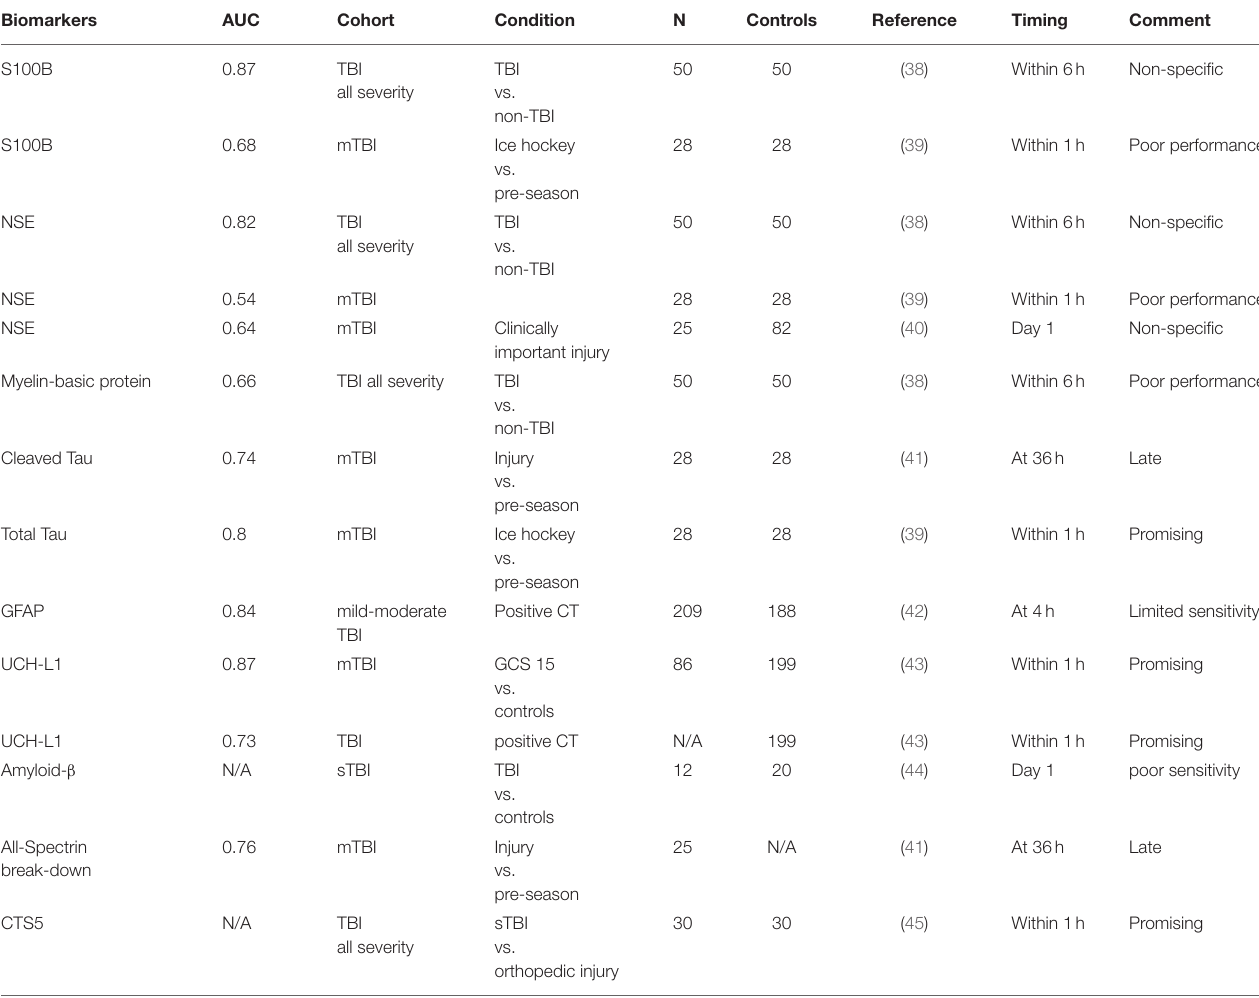
TABLE 1 | Area under the curve (AUC) of representative TBI biomarkers.